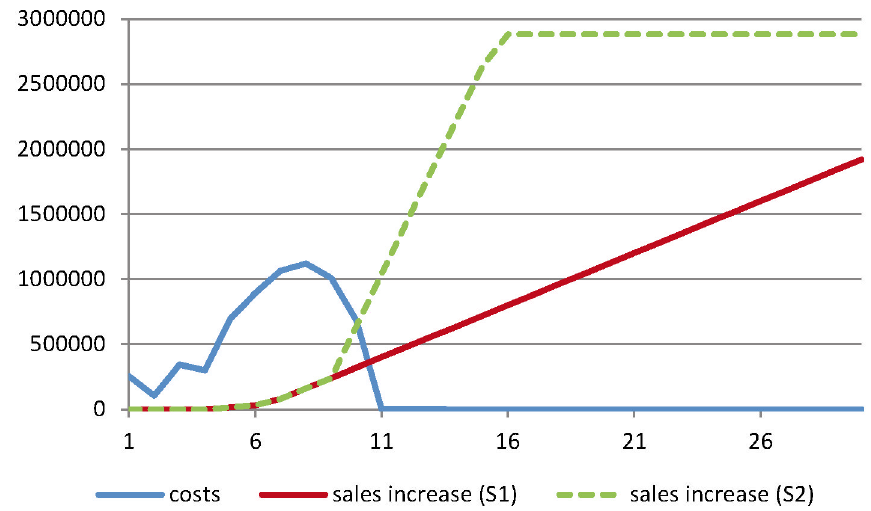
Figure 6. Comparison of the total costs of the project and increase in global cattle sales. The figures (Euros) concern the Niayes area over a period of 30 years after the beginning of the project. Cattle sales include meat and milk sales. S1 corresponds to the scenario with a constant 2% annual replacement rate from traditional trypanotolerant farming systems to improved farming systems, and S2 to the scenario with an accelerated replacement rate according to the sociology of innovation (see text for details).